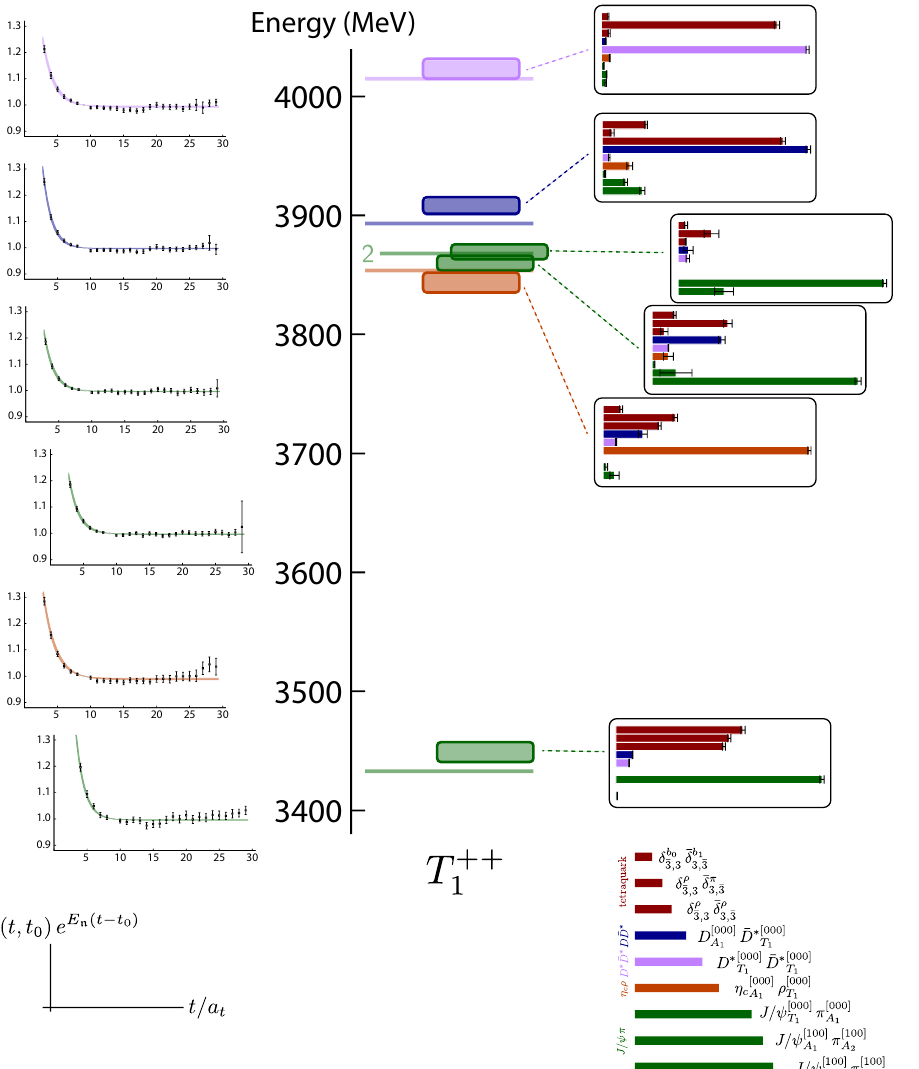
Figure 4 . The central plot shows the spectrum in the hidden-charm isospin-1 (cid:3) PG = T ++